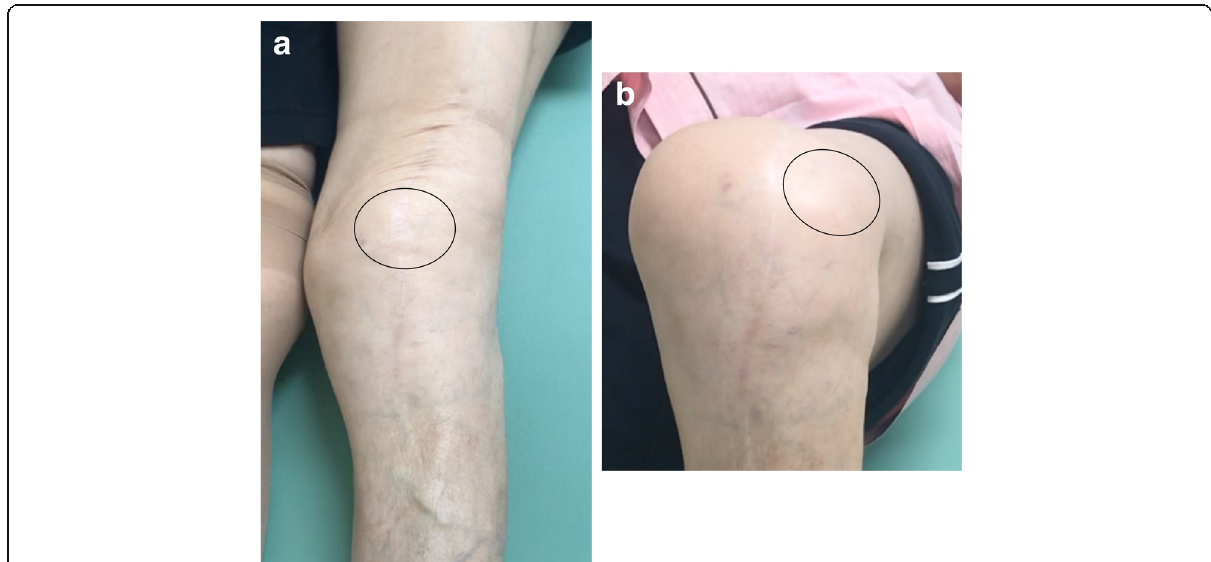
Fig. 1 Macroscopic photographs of the clinical findings in the study patient. a Patella reduced in the extended knee. b Patella dislocated laterally in the flexed